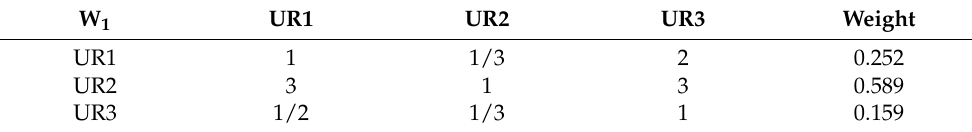
Table 7. Relative weights of each UR (W 1